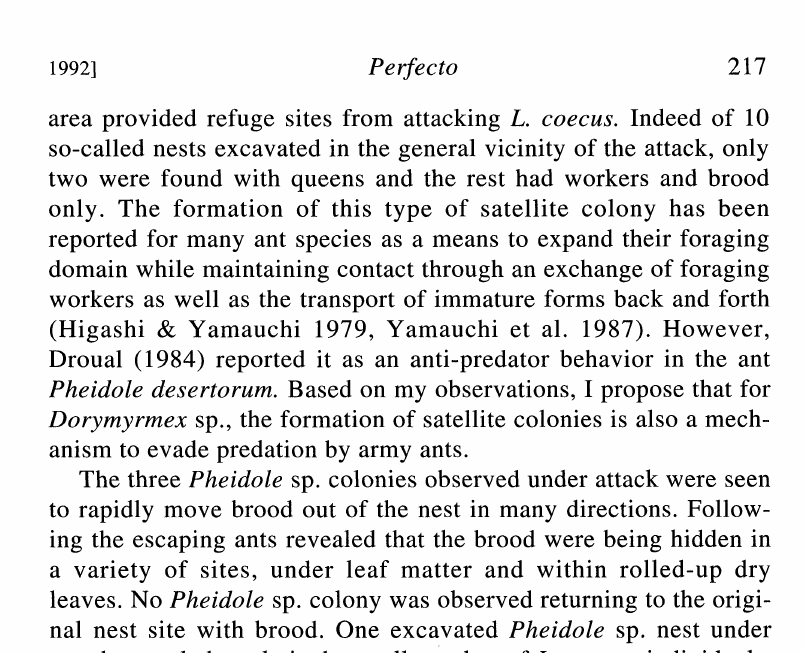
Figure 1. Sketch of the area raided. Large shaded areas indicate approximate area of the canopy of individual coffee bushes. Small squares indicate Brachymyrmex sp. nest openings, open triangles those of Pheidole sp., circled squares those of Pheidole radoszkowskii, solid ovals those of living (shaded) and dead (unshaded) Solenopsis geminata. Arrows indicate nest openings from which and to which brood were taken by Dorymyrmex sp. Numbers indicate approximate times that each nest was raided (1 09:00, 2 10:00, 3 11:15, 4 11:30, 5 11:45, 6 12:00, 7 13:30). Note that the S. geminata nest at the bottom of the figure is about 12 meters from the concentration of the earlier part of the raid, and is included in the figure out of scale, as indicated by the jagged lines. The lower left scale indicator refers to the rest of the